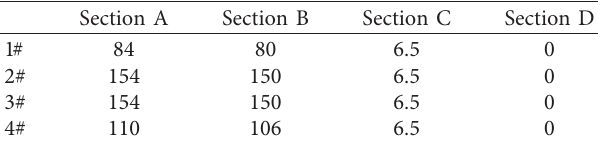
Figure 3: Wolonggou Bridge. (a) A general view of the bridge. (b) The schematic diagram of the midspan section. (c) The schematic diagram of the section at the supports. (d) Key sections of the piers (unit: m). Table 2: The distance between the key section and the bottom of the pier (unit: